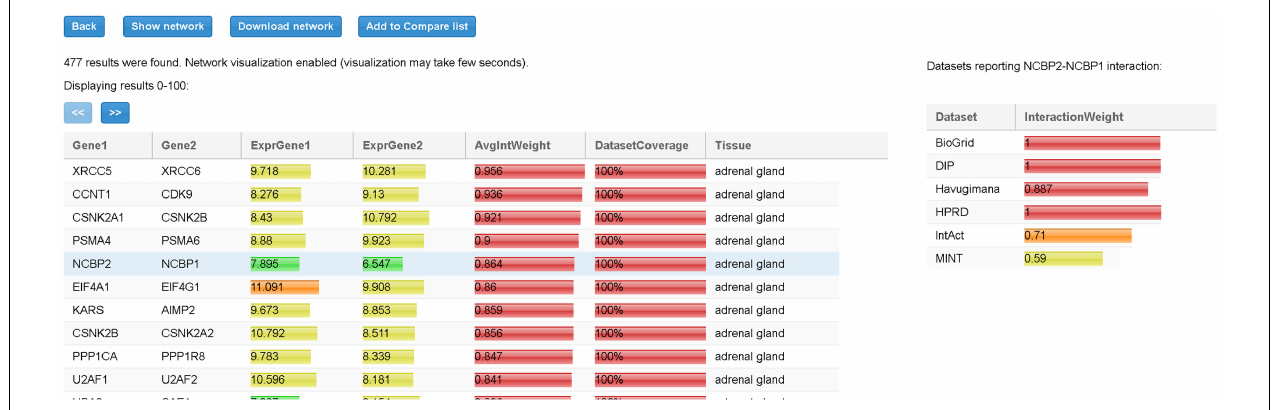
selecting a row (in the example the interaction between NCBP2 and NCBP1), detailed data about the interaction are shown to the right. For each dataset, the corresponding interaction weight (when available) is reported (for example, 0.71 for IntAct